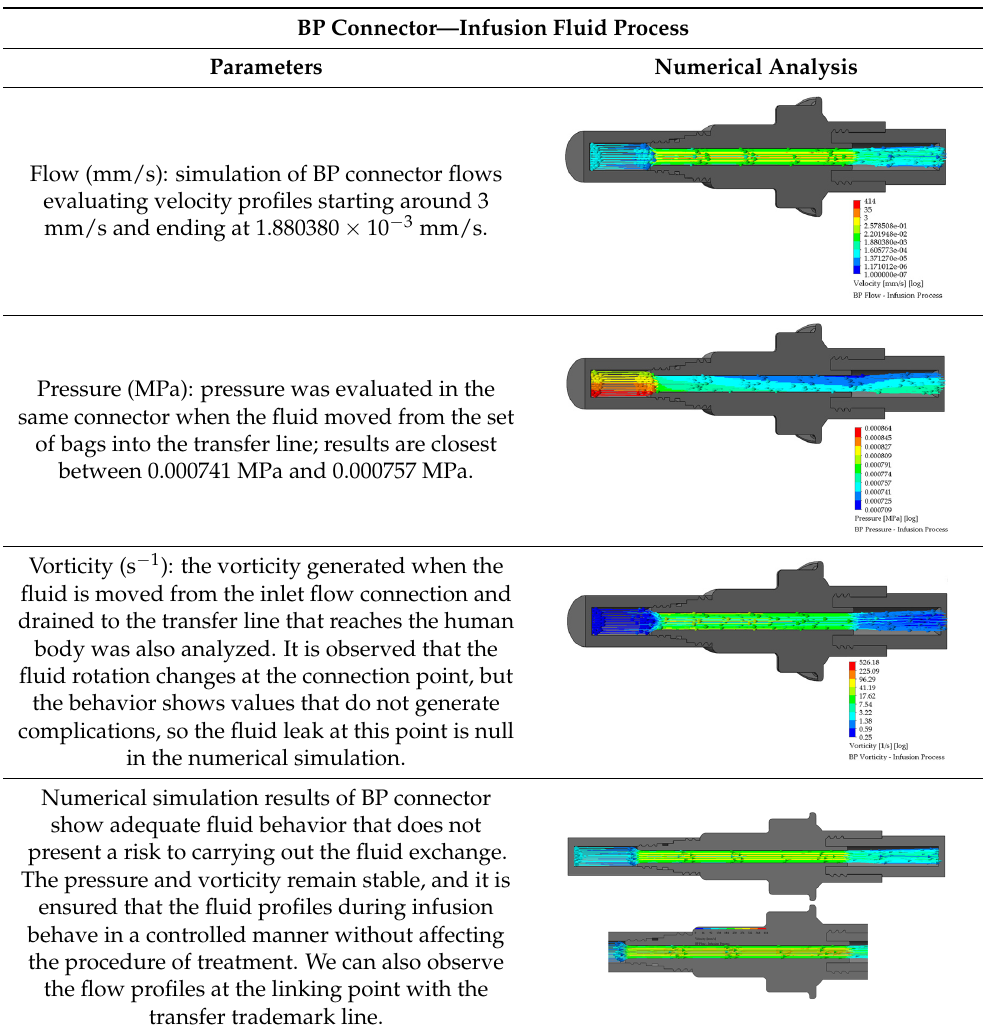
Figure 7. PB connector, join points, and thread features.